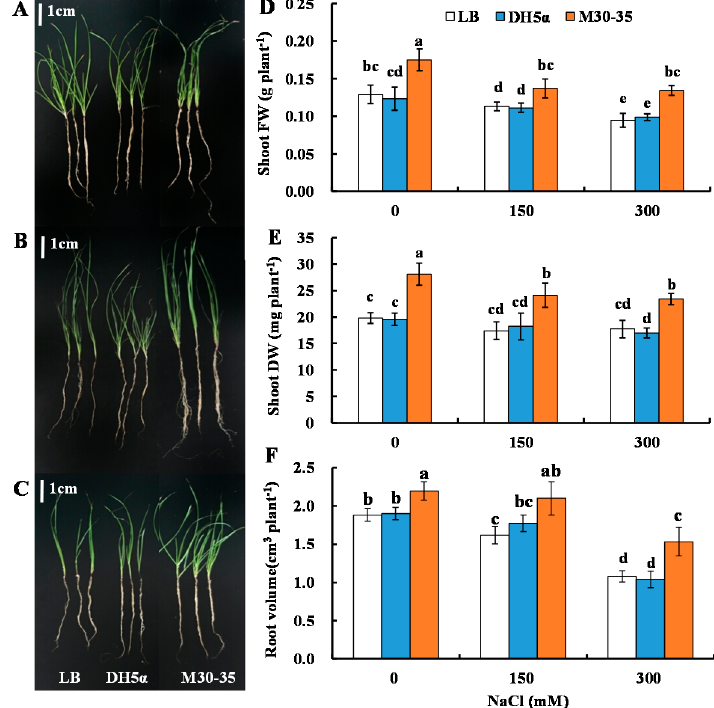
Figure 1. Effects of M30-35 on whole plant growth ( A – C ), shoot fresh weight (FW) ( D ), shoot dry weight (DW) ( E ) and root volume ( F ) of ryegrass under various salt treatments (0, 150 and 300 mM NaCl). For ( A – C ), from left to right: Luria broth (LB) medium, DH5 α and M30-35 treatments; from top to bottom: 0, 150 and 300 mM NaCl treatments. Values are means and bars indicate standard errors (SEs) ( n = 12). Columns with different letters indicate significant differences among treatments at p < 0.05 (ANOVA and Duncan’s multiple comparison test).